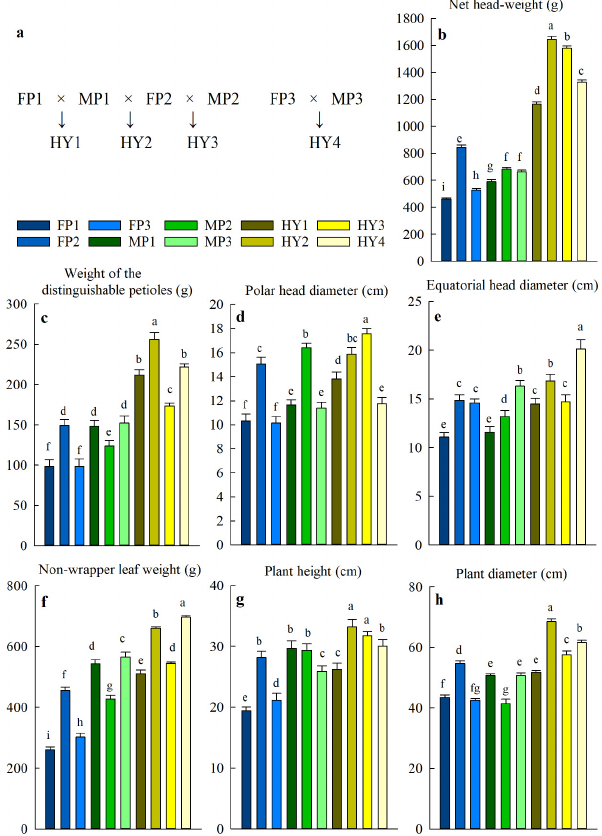
Figure 1. The crosses used for the generation of hybrids and the differences in the cabbage head and plant size traits. ( a ) The female parent (FP) and the male parent (MP) crosses used to obtain different cabbage hybrids (HY). HY1 and HY2 share the MP; HY2 and HY3 share the FP; HY4 does not share parents with any other hybrid. ( b–h ) Variation of cabbage head size and plant size among cabbage hybrids and parents. Data are means ± SD, n = 3 blocks, with each block representing the average of 10 cabbages. Different letters denote statistical differences as determined by one-way ANOVA coupled with LSD post-hoc test ( p < 0.05).